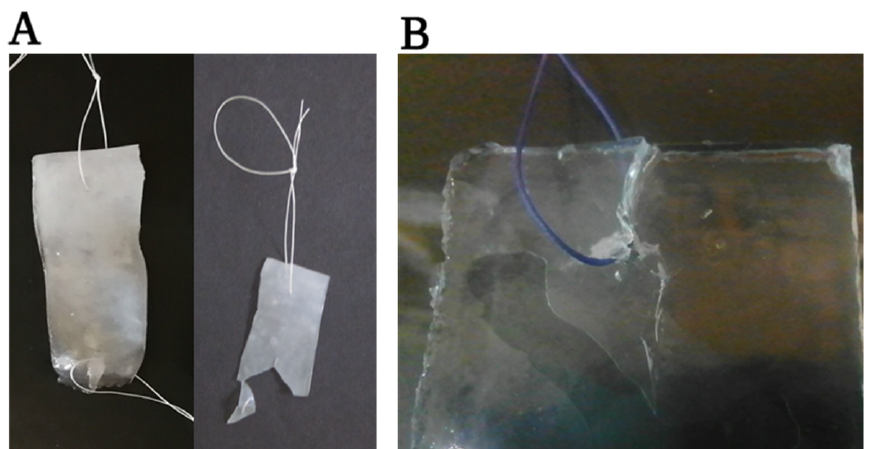
Figure 15. Suturability of poly(vinyl alcohol) electrospun membranes before and after uniaxial measurement ( A ) and bulk hydrogels ( B ).